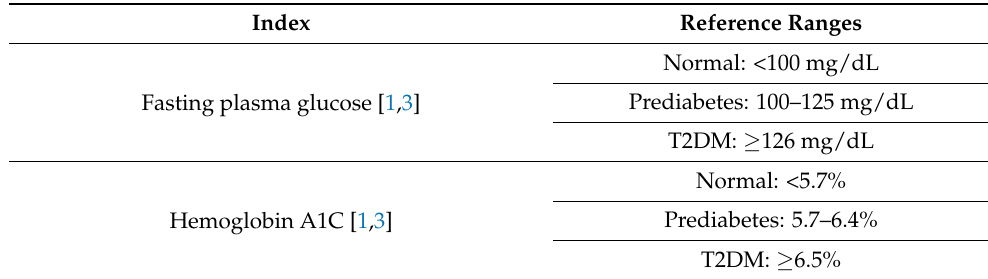
Table 1. Clinical classifiers and their reference ranges for disorders of glucose